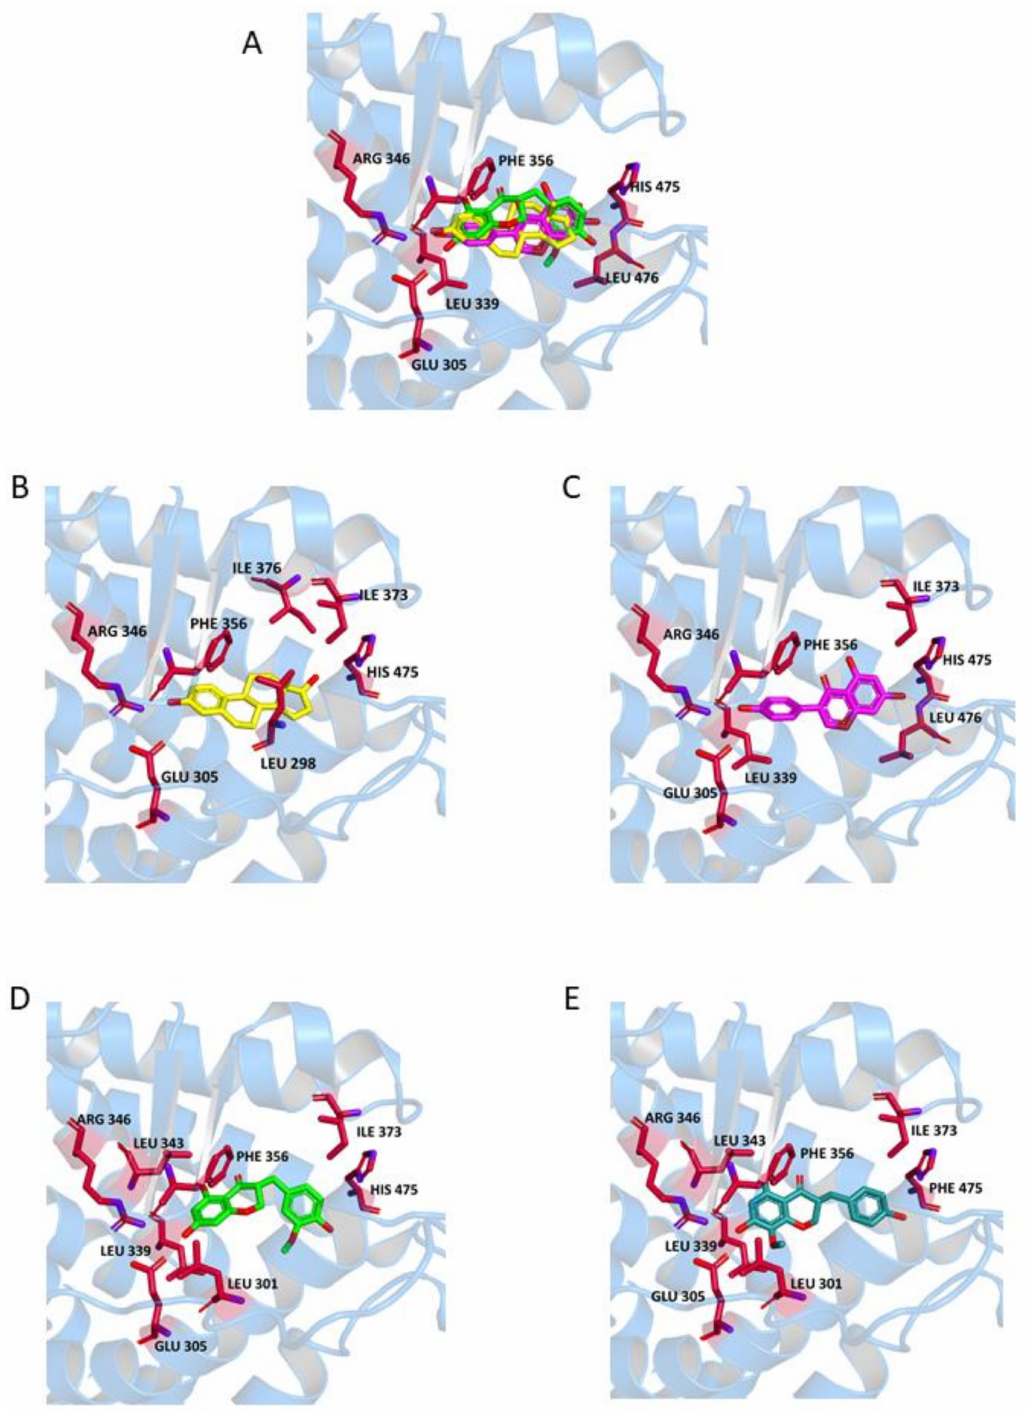
Figure 6. Ligand-binding pocket of the active site of ER β ; ribbons representing protein structural elements are also shown. ( A ) Superimposed binding modes of all the four ligands: E (yellow), G (magenta), (R)-N1 (green), and (R)-N2 (cyan); the key residues are also indicated in the specific binding mode of ( B ) E ; ( C ) G ; ( D ) (R)-N1 ; and ( E ) (R)-N2